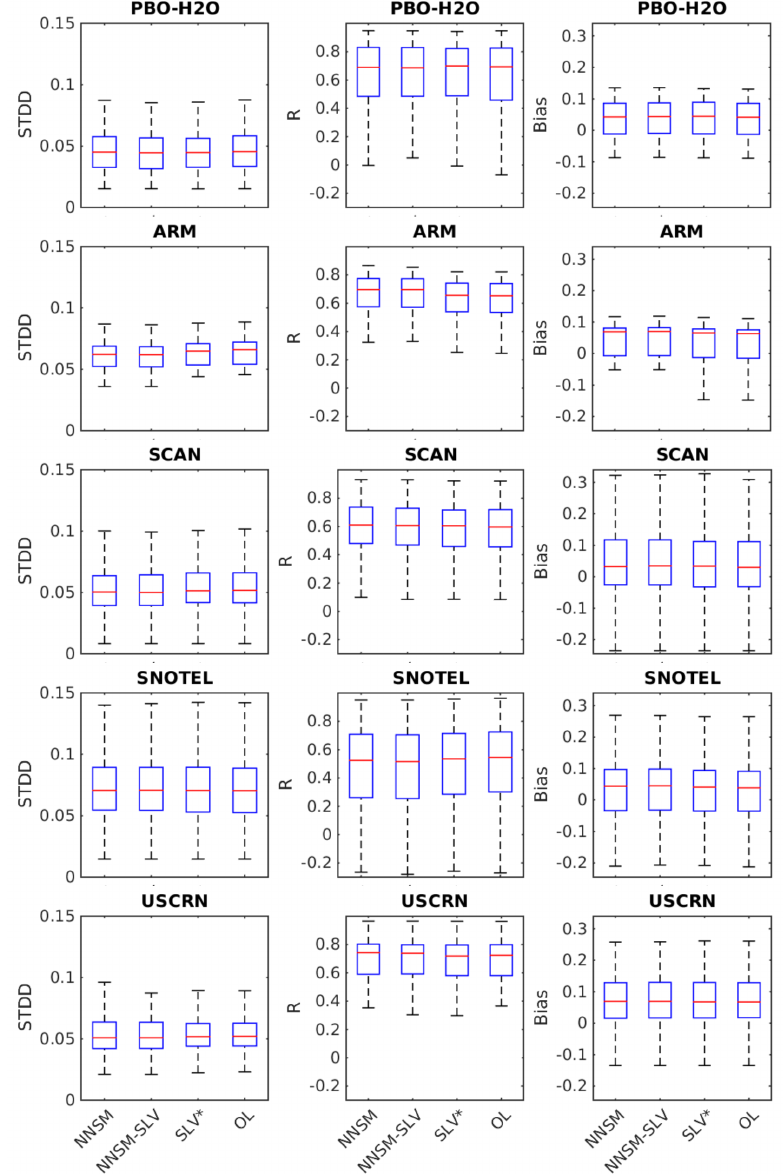
Figure 8. Same as Figure 7 for networks located in North